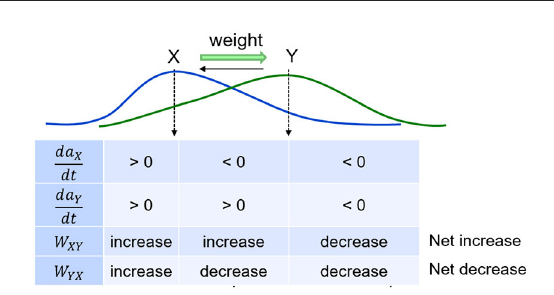
FIGURE3 Weights develop as a function of item activations. Weights learn to be directional from earlier items to later items in a sequence.